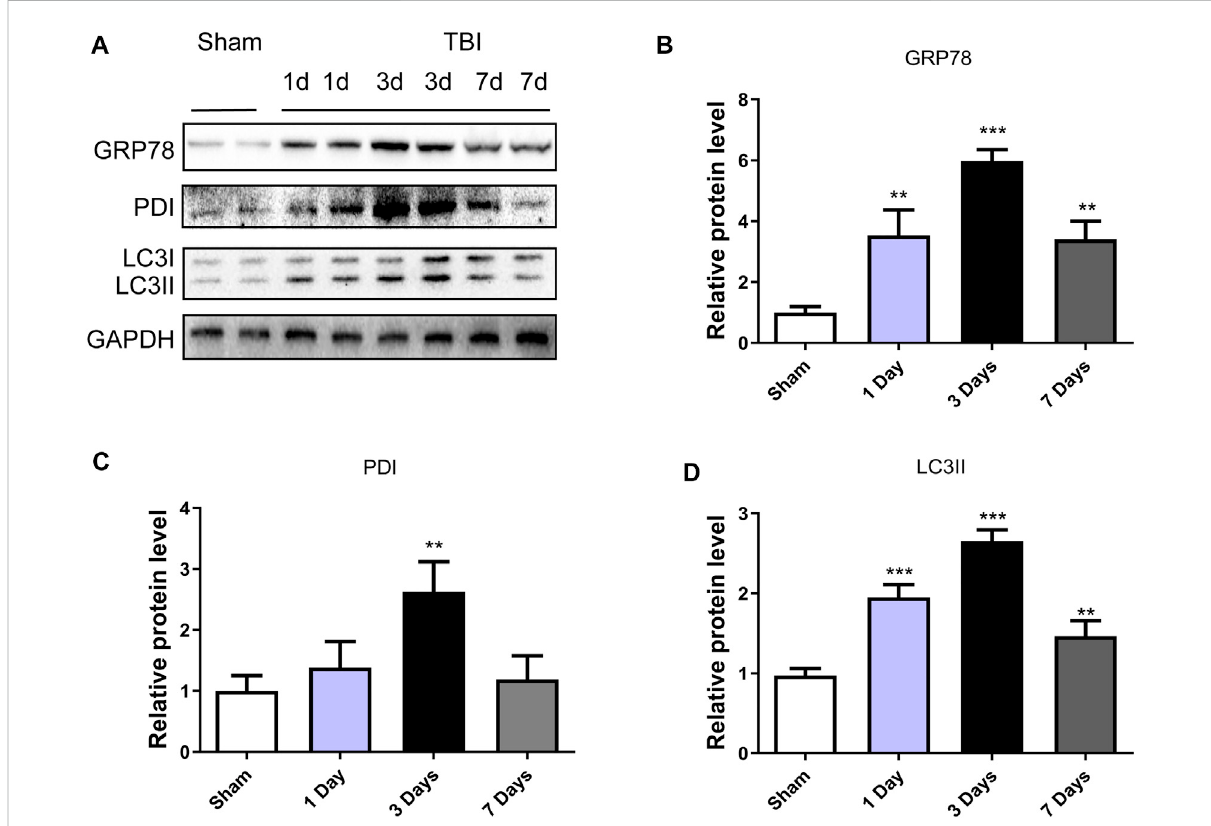
FIGURE 1 TBI activates ER stress and autophagy. (A) Representative western blot analyses of GRP78, PDI and LC3I/II in the cerebral cortex from sham groupand1 day,3 daysand7 dayspost-injurygroup. (B – D) Quanti fi cationofGRP78,PDIandLC3IIintheipsilateralbraincortexat1d,3dand7dafter TBI. Data represent the mean ± SD, n = 3, ** p < 0.01 and *** p < 0.001 vs. the sham